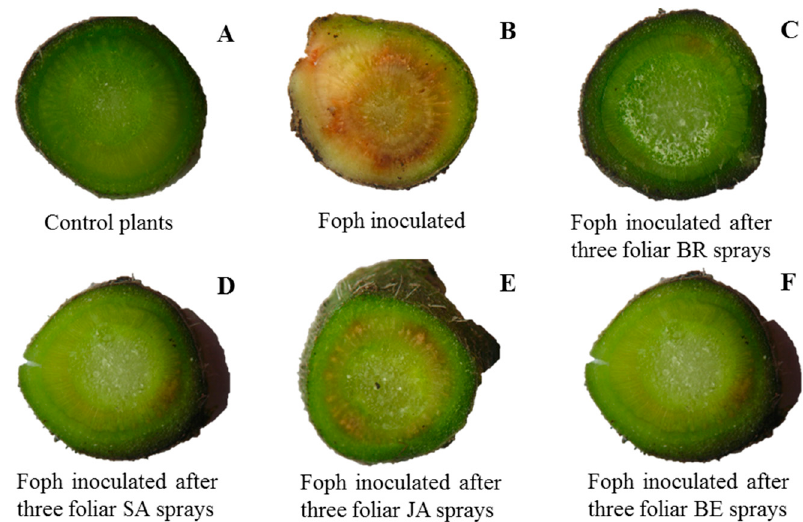
Figure 2. Effect of the interaction between synthetic elicitors (Salicylic acid (SA), jasmonic acid (JA), Brassinosteroids (BR), or botanical extracts (BE)) and the sprays number (0, 1, 2 and 3 applications) on control efficacy in Fusarium oxysporum f. sp. physali infected cape gooseberry ( Physalis peruviana L.) plants at 50 DAI. Data represent the average of ten plants ± SE per treatment ( n = 10). Bars followed by different letters indicate statistically significant differences according to the Tukey test ( p ≤ 0.05).